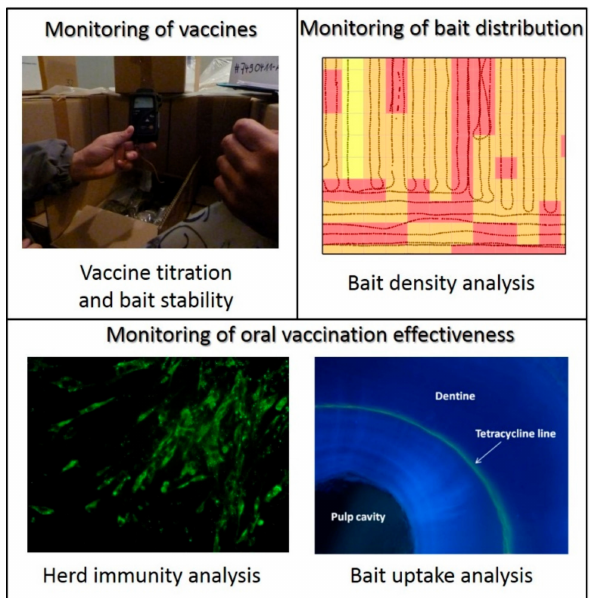
Figure 1. Quality control parameters used in the EU to evaluate the implementation and e ffi cacy of oral vaccination